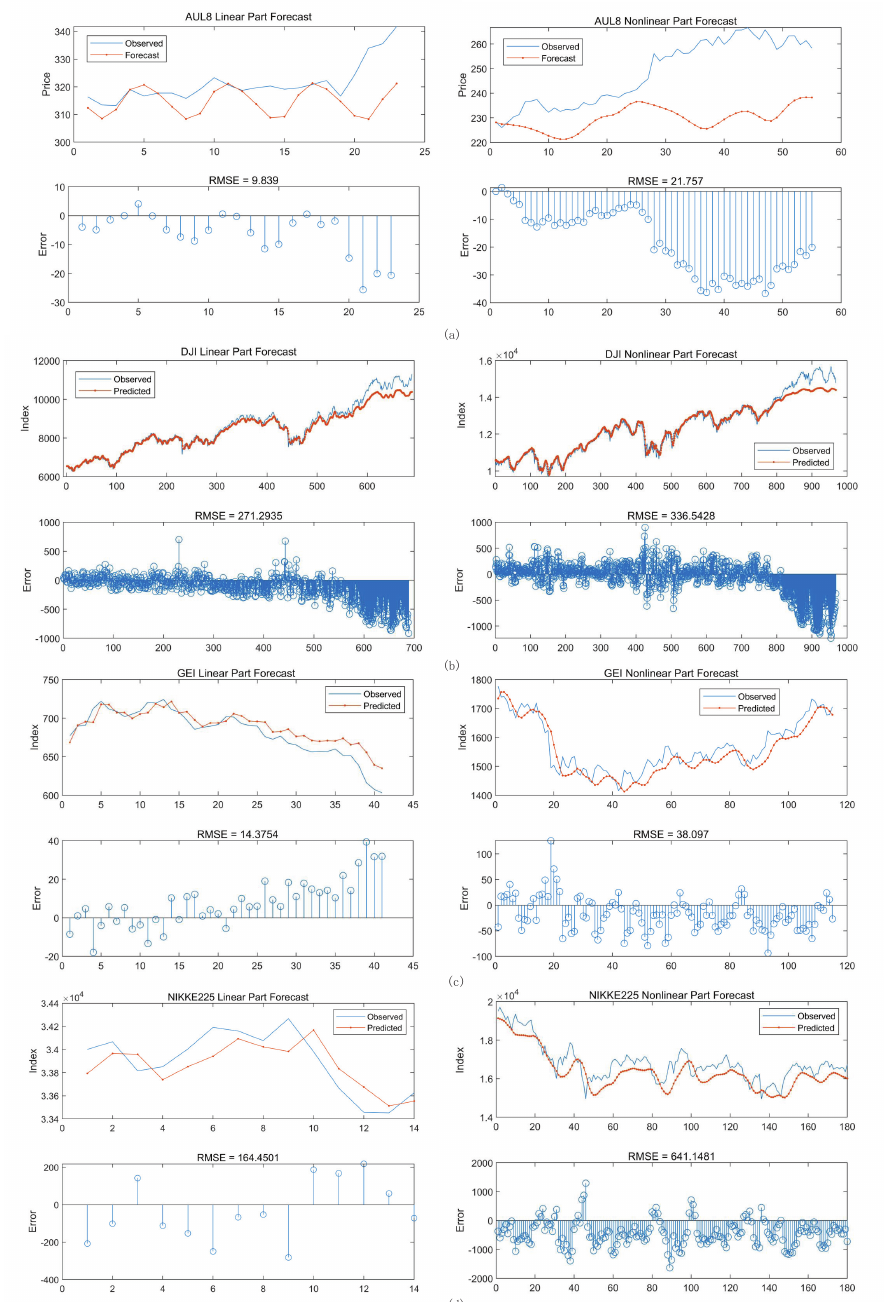
Figure 7. Four time series ( a ) AUL8, ( b ) DJI, ( c ) GEI and ( d ) NIKKE225. predictions with different groups (trend to linear part or trend to nonlinear part), and the RMSE in every small forecast